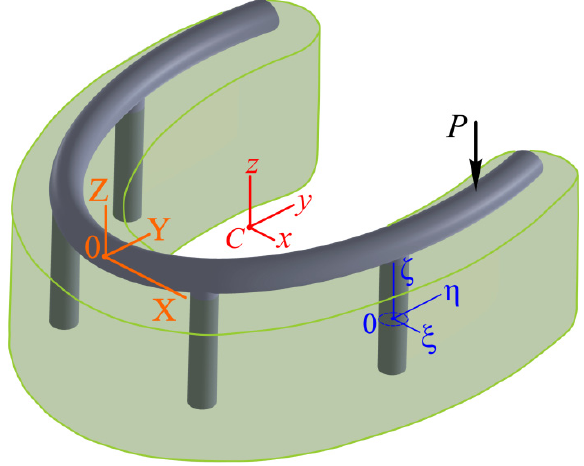
Figure 3. Calculation scheme of the force interaction of the elements of the bar structure as an as- sembly (implants–bar–overdenture).